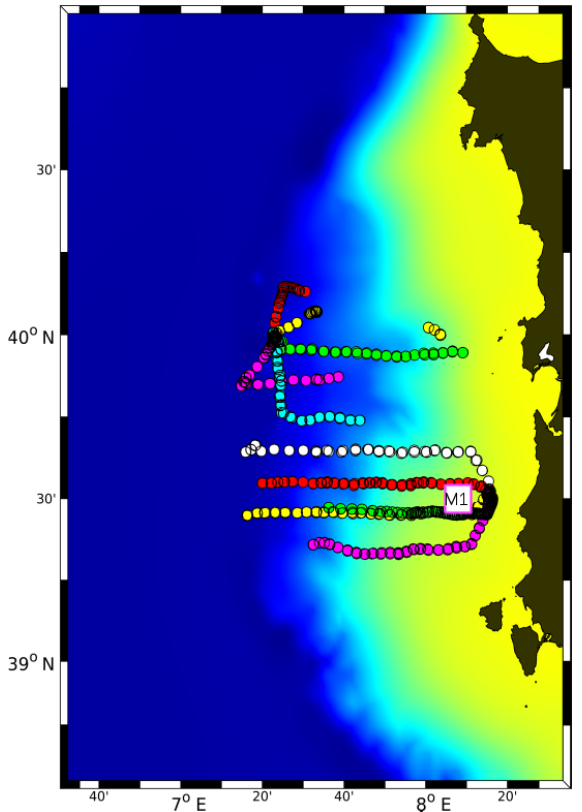
Figure 7. The actual surfacing positions of all assimilated gliders during 7–11 June. Each glider is marked by a different colour. The colour code for the bathymetry is the same as in Fig.